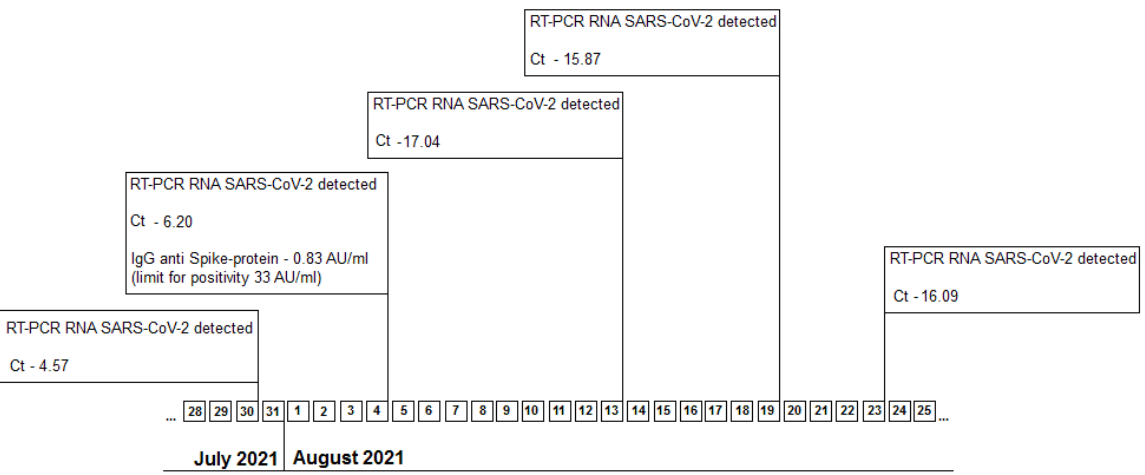
Figure 1. Timeline for real time RT-PCR testing for SARS-CoV-2 between 30 July and 23 August 2021. Legend: Ct-cycle-threshold.